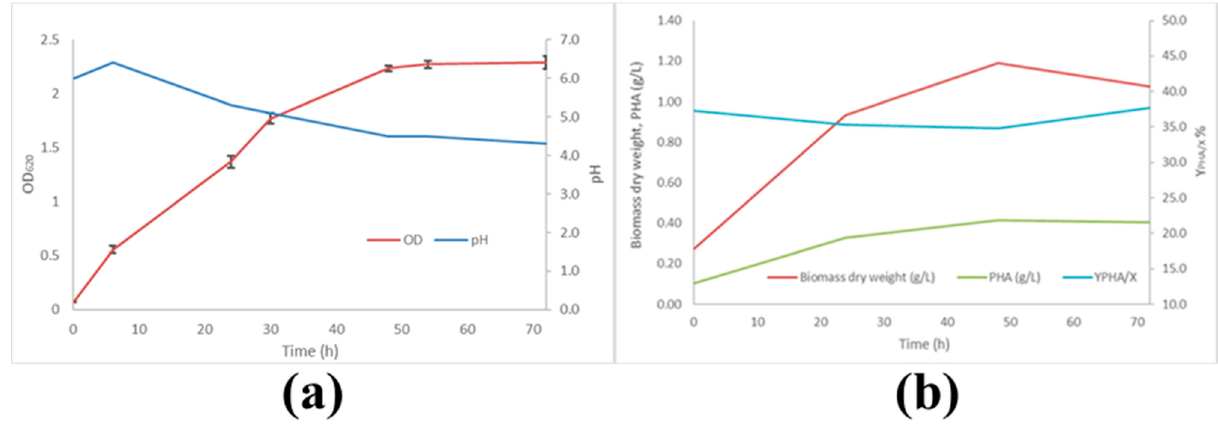
Figure 1. Growth and PHA production kinetics of MMC cultures in scotta cheese whey: ( a ) OD 620 and pH; ( b ) biomass dry weight, PHA concentration, and PHA yield (data obtained from triplicate experiments).